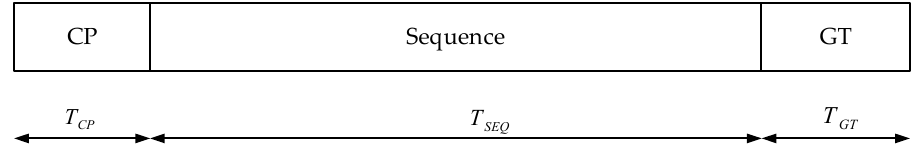
Figure 3. PRACH channel format.